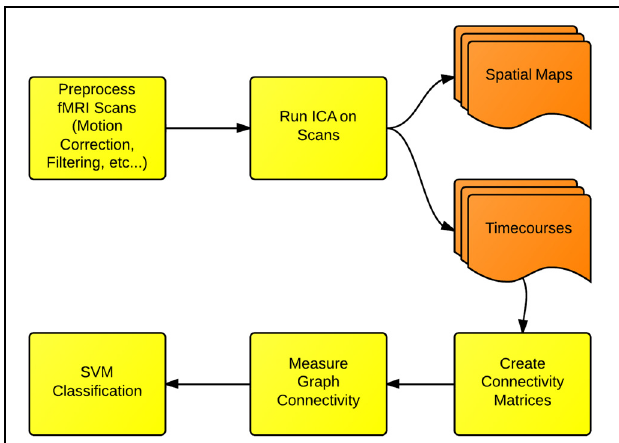
FIGURE 1 | Functional network connectivity (FNC) and classification: the first step in FNC is to define the scale of connectivity to observe. In this case, we use whole-brain networks obtained from ICA, but this analysis also can be implemented on the region-of-interest or the voxel scale. The connectivity is defined and measured to identify differences between either groups or